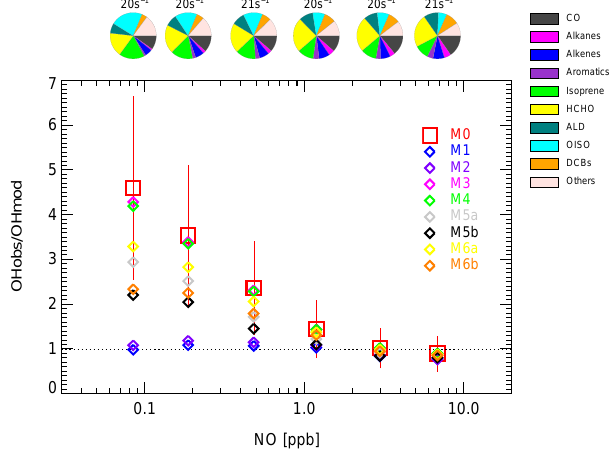
Fig. 13. NO dependence of the observed-to-modelled OH ratio ( OH obs / OH mod ) for the different mechanistic scenarios M0 to M6 (see Table 5). Vertical error bars denote the combined 1 σ accuracies of the modelled (M0) and observed OH concentrations. Total VOC reactivities (M0 case) and their organic speciation (with- out NO x ) are presented by pie charts at different NO intervals ( ∆ ln([NO]/ppb) = 0.17) at the top. Abbrev. in the color legend of the pie charts: ALD = higher aldehydes than HCHO, OISO = MACR + MVK + CAR4, DCBs = MGLY + GLY + DCB, others = degradation products from hydrocarbons listed in Table 2 that exclude HCHO, ALD, OISO,